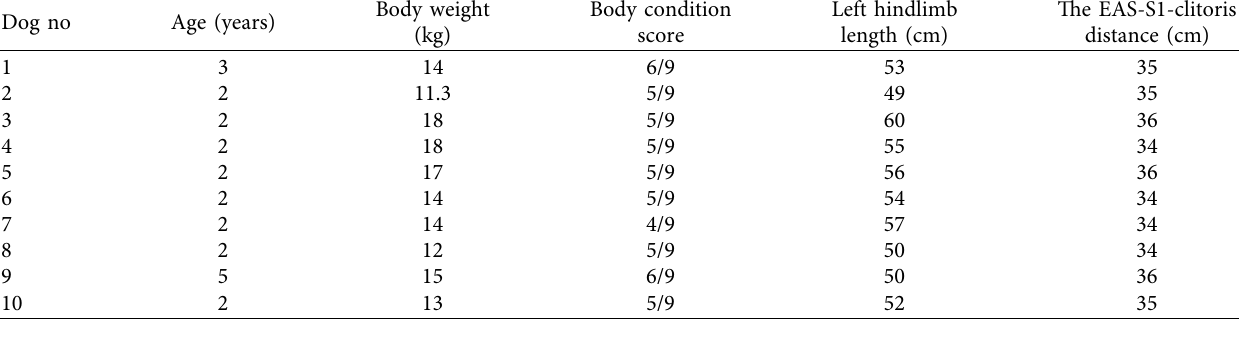
Table 1: Data from 10 spayed female dogs.